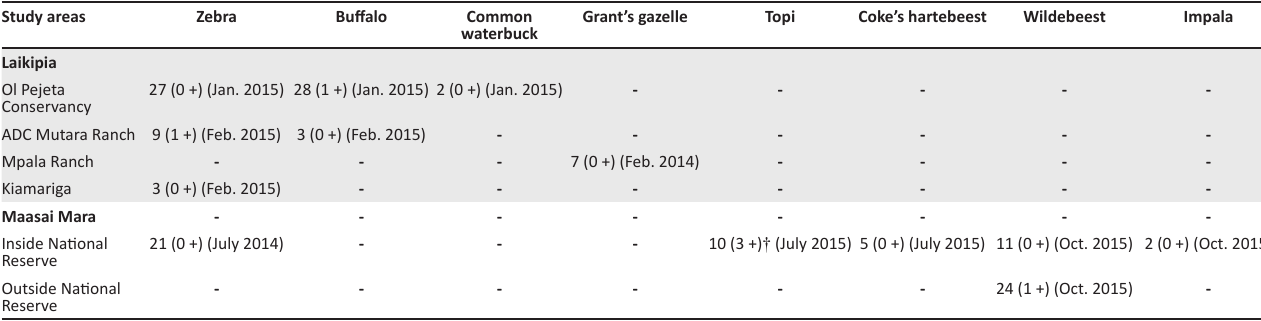
TABLE 2: Animals sampled in each site in both study areas and corresponding dates. Study areas